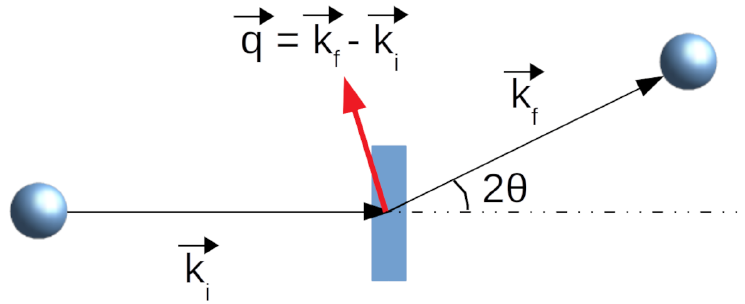
Figure 2. Definition of the scattering vector (cid:126) q , which is shown in